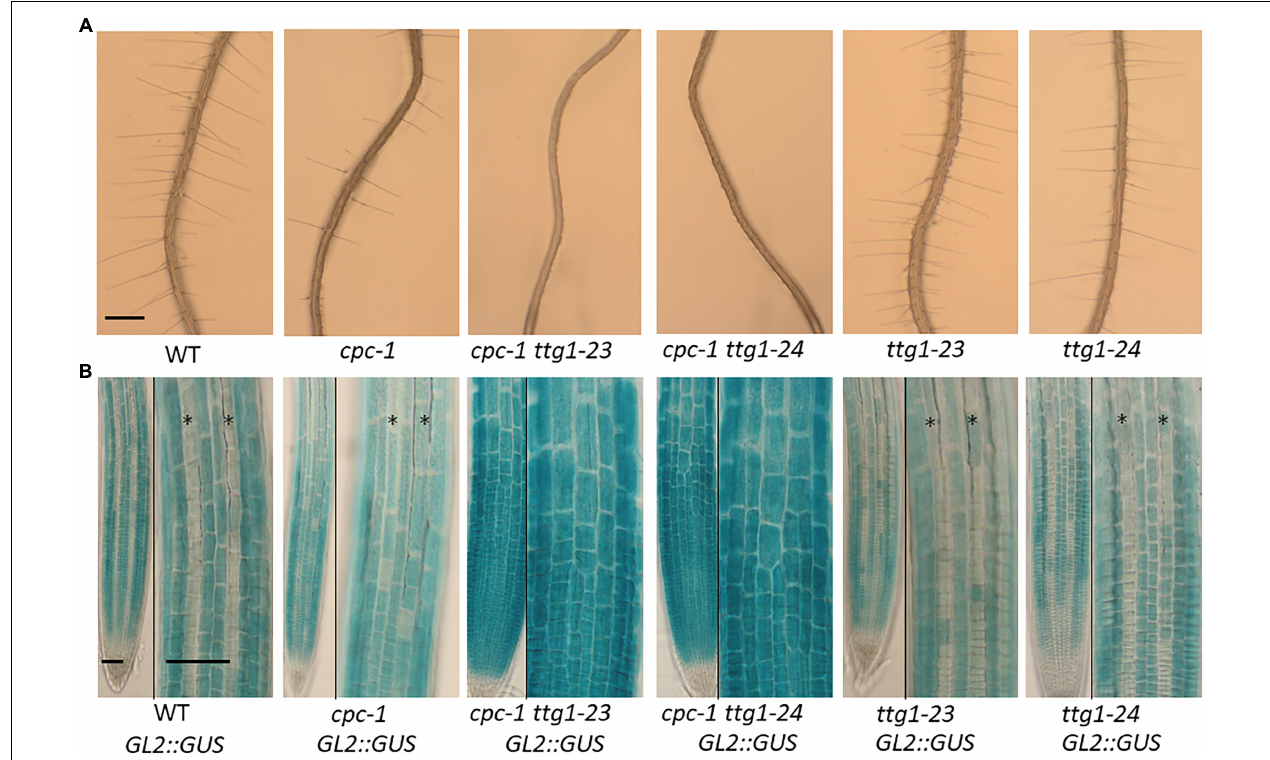
FIGURE 1 | Characterization of the ttg1-23 and ttg1-24 mutants. (A) Seedling roots of wild type, cpc-1 , cpc-1 23 , cpc-1 24 , 23 , and 24 displaying their root hair phenotypes. Bar = 200 µ m. (B) GL2:GUS reporter expression in seedling root tips of wild type, cpc-1 , cpc-1 23 , cpc-1 24 , 23 , and 24 . Stars indicate H-position epidermal cell files. For each panel, the left and right images show the same root under different magnification. Bar = 50 µ m.